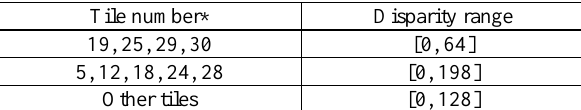
Table 1. Selected disparity range for each image tile